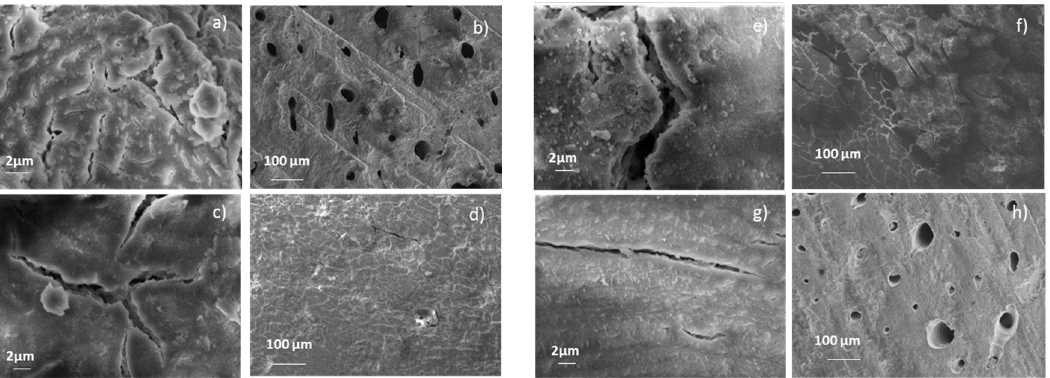
Figure 1. SEM images of representative female and male donor bone samples: F34 ( a , b ), F41 ( c , d ), M40 ( e , f ), M45 ( g , h ).